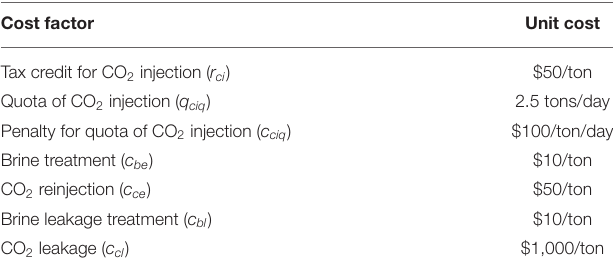
TABLE 4 | Cost factors and unit costs for brine extraction.